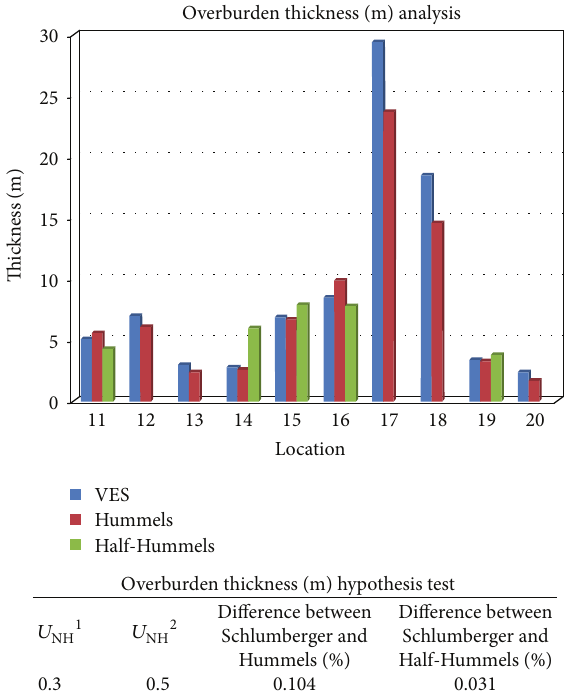
Figure 25: Bar chart and statistical test of hypothesis table for the different array methods comparing overburden thickness for locations on